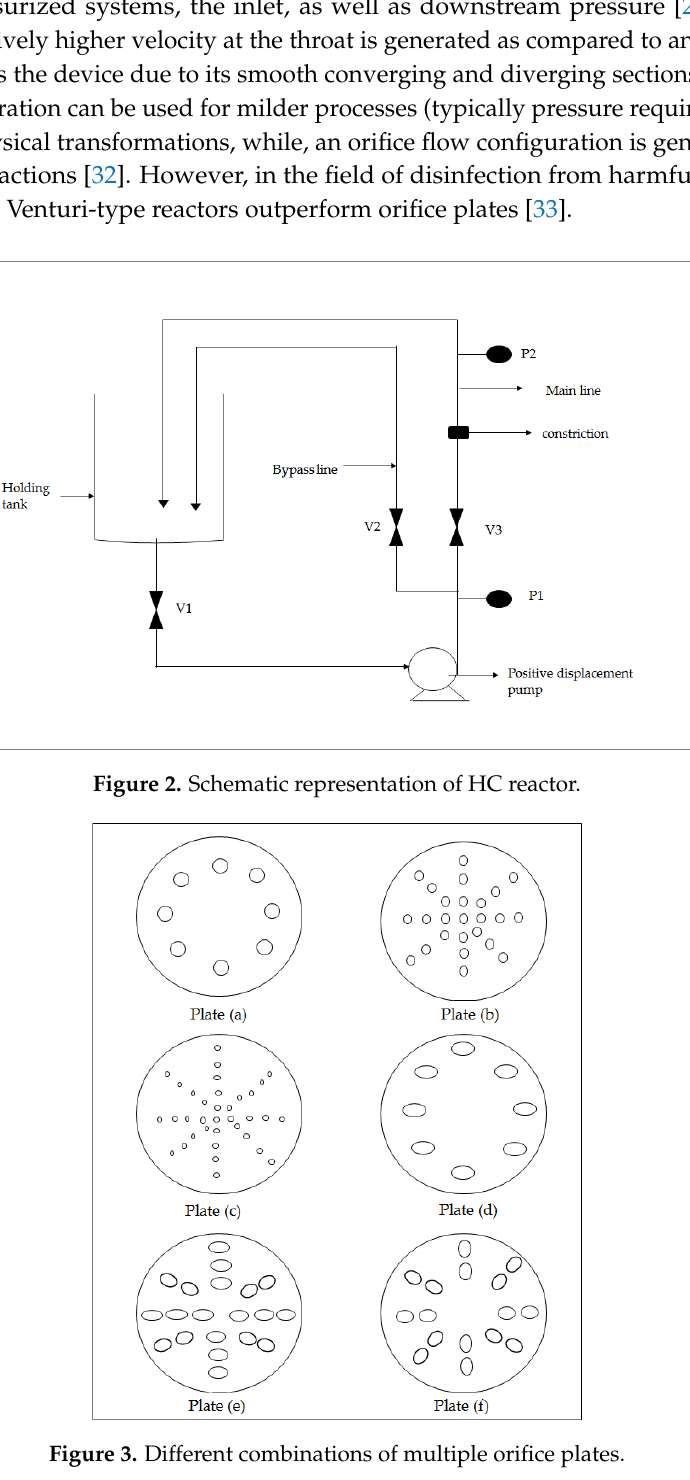
Figure 3. Different combinations of multiple orifice plates.